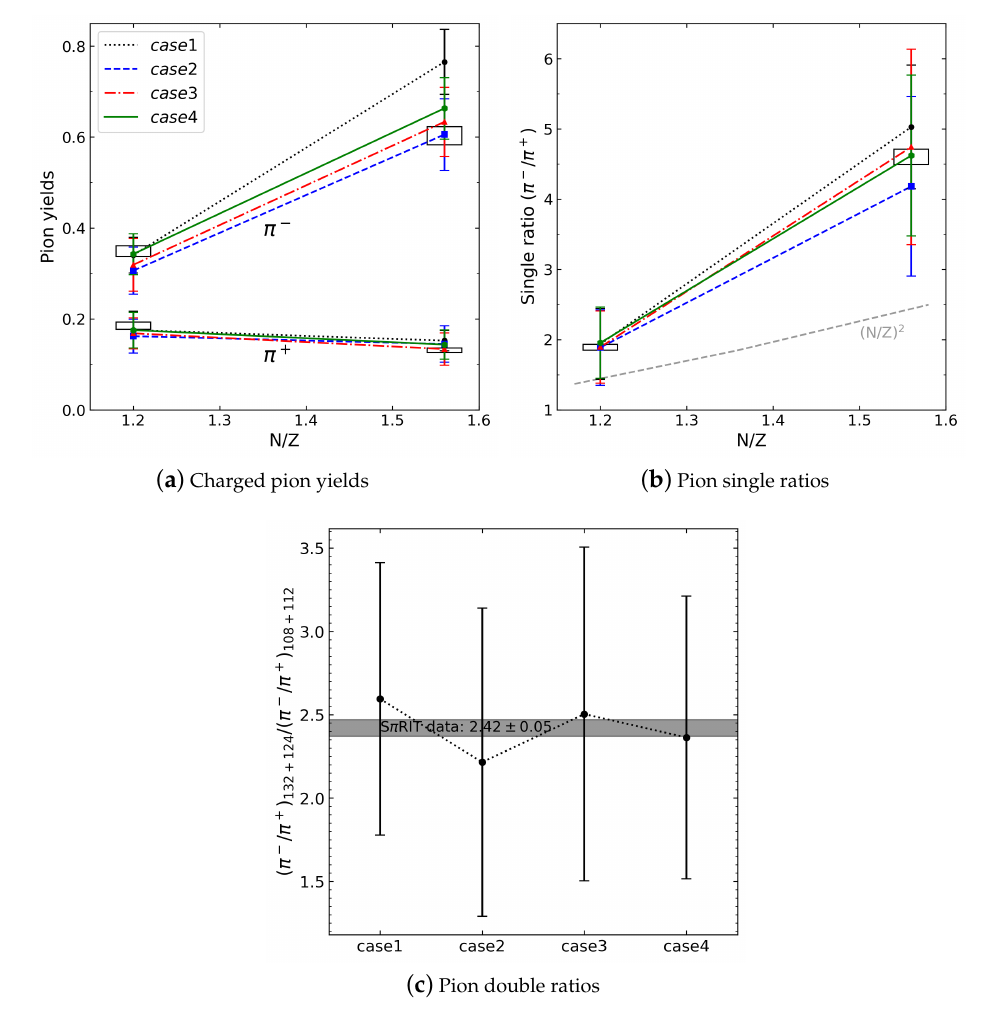
Figure 2. ( a ) Charged pion multiplicities as a function of N / Z for neutron-poor ( N / Z = 1.2) systems and neutron-rich ( N / Z = 1.56) systems . Upper (lower) four lines are for π − ( π + ). We consider four difference cases as given in Table 3. ( b ) Charged pion single ratios as a function of N / Z for four cases. All the empty boxes in ( a , b ) are experimental data with uncertainties. ( c ) Double ratios for 132 Sn+ 124 Sn and 108 Sn+ 112 Sn for four different cases. Experimental data are marked as a gray box. Note that the statistical errors are quite large because the number of produced pions per run is very